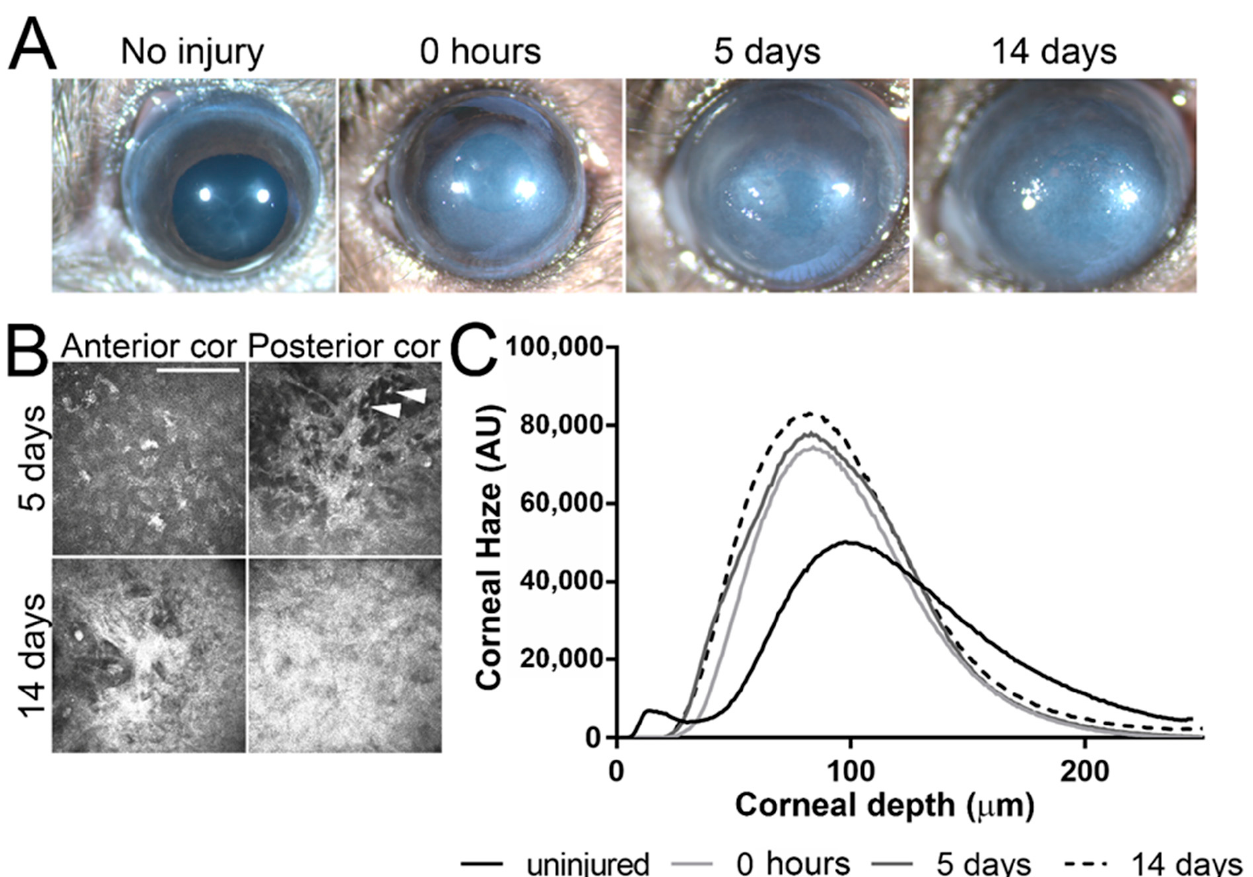
Figure 1. Corneal morphology and haze after AB. Corneas were imaged under a stereomicroscope prior to and immediately, 5 days and 14 days after AB, and, a representative image shown ( A ). Corneas were analyzed by in vivo confocal microscopy at 0, 5, and 14 days after AB and a representative images of the anterior and posterior stroma shown ( B ). Scale bar 50 µ m. Inflammatory cells are present at 5 days after AB, indicated with a white arrowhead. In order to evaluate corneal transparency, a z-stack of images was acquired through the entire corneal stroma at 2 µ m increments and corneal haze quantified in each frame using Fiji (Image J-win64 by NIH) and plotted as a histogram. Representative histograms are presented ( C ). All mice included in this study were analyzed under a stereomicroscope at each indicated time point and five mice from each experimental group were analyzed by in vivo confocal microscopy at each indicated time point. Table 1. Heparin/heparan sulfate content in corneas of wild-type mice 5 and 14 days after AB.